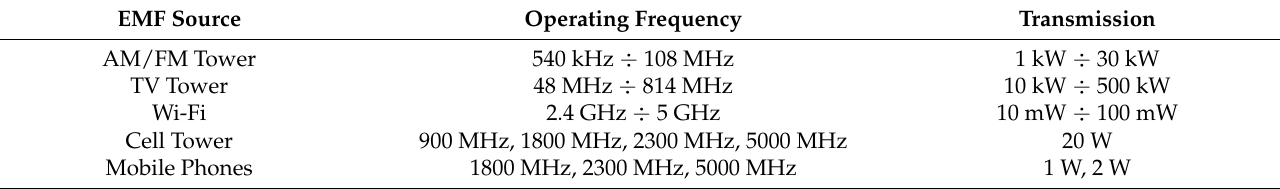
Table 1. EMF sources and operating frequencies